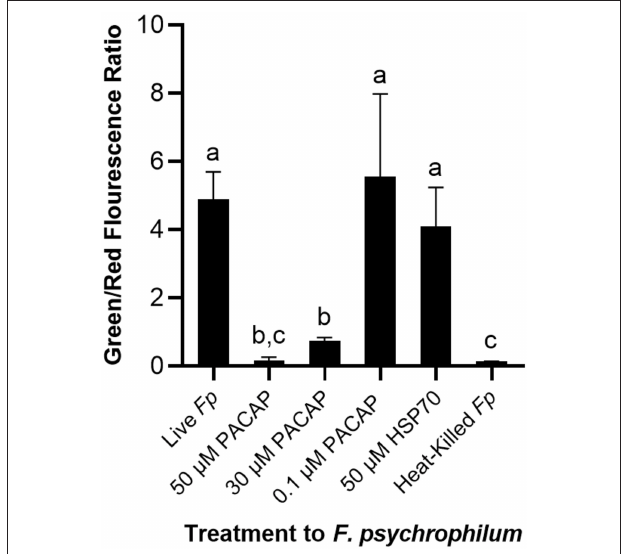
FIGURE 4 | Disruption of F. psychrophilum membrane by PACAP-38 of C. gariepinus . Live F. psychrophilum was grown alone, in the presence of PACAP-38 (50, 30, and 0.1 µ M) and in the presence of a control synthetic peptide fragment of comparable size, 50 µ M HSP70 (1.3 kDa). As a negative control, heat-killed F. psychrophilum was also included. Following a 3 day incubation at 14 ◦ C, all experimental wells were exposed to BacLight which would cause live bacterial cells to fluoresce green (SYTO9) and permeabilized cells to fluoresce red (propidium iodide). The ratio of green/red fluorescence was calculated, and this value was compared between conditions. This experiment was replicated four times and the averages are presented as the means + SD. A p < 0.05 was considered to be statistically significant. Lowercase letters denote significant differences at p <